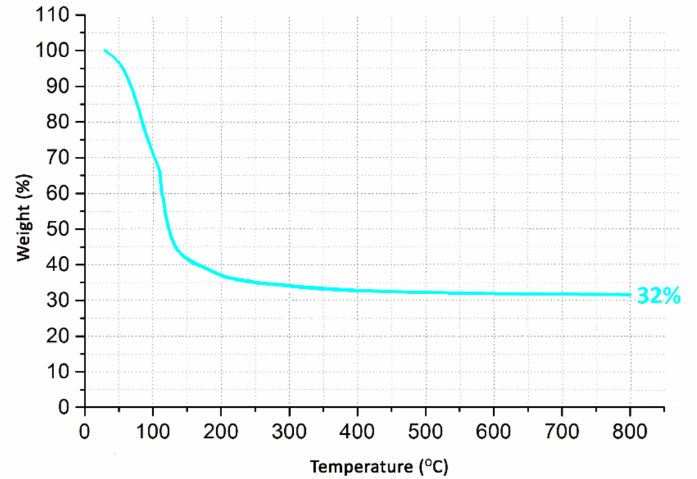
Figure 4. TGA curve of